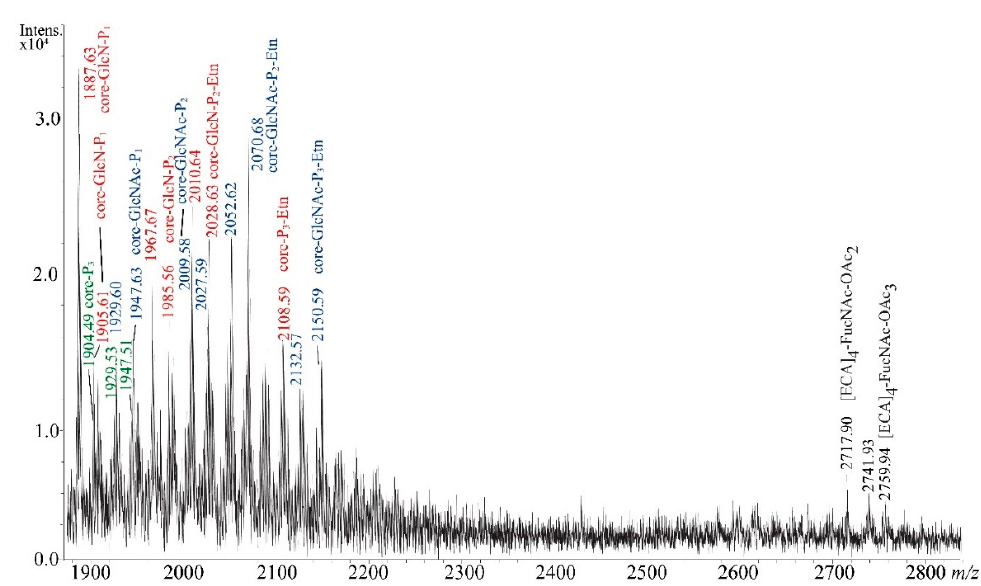
Figure 6. Negative-ion mode MALDI-TOF mass spectrum of fraction 5 isolated from E. coli R3 LOS preparation. The interpretation of ions is shown in Table 5. The core stands for Glc 3 -Gal-GlcNAc- Hep 3 -Kdo oligosaccharide. Colors green, red, and blue refer to three R3 core OS glycoforms (Figure 1). Table 5. Interpretation of negative-ion mode MALDI-TOF mass spectra of fraction 5 isolated from E. coli R3 LOS preparation.